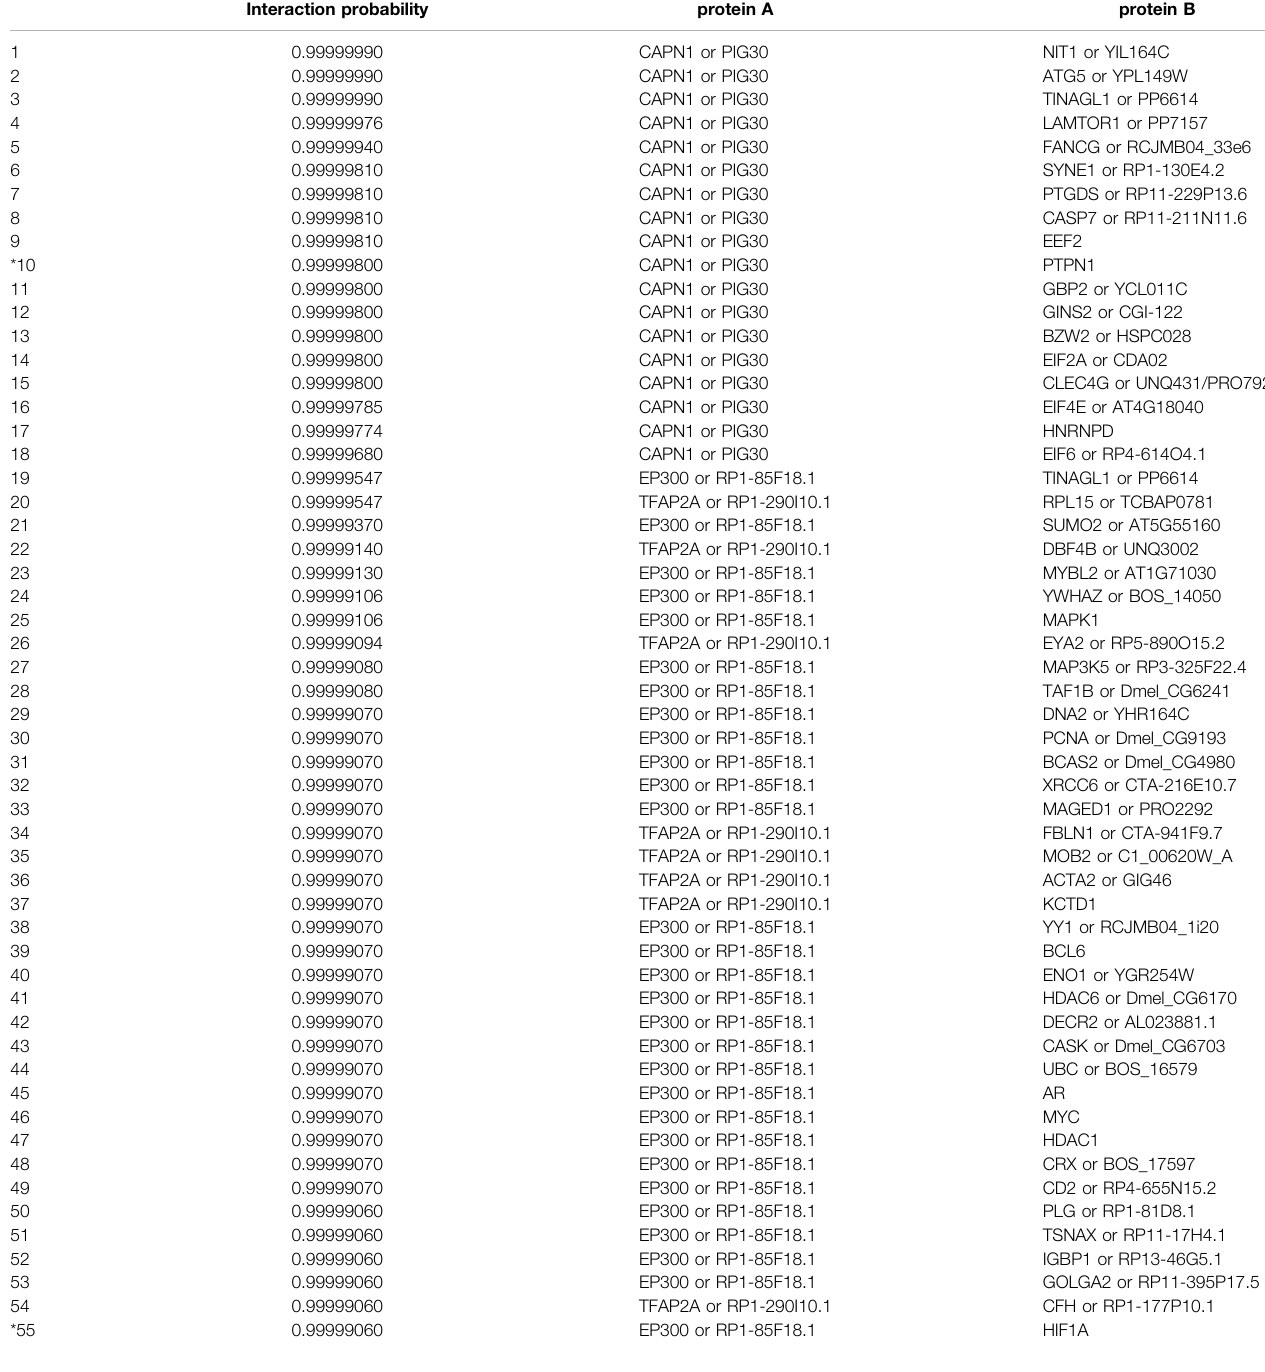
TABLE A1 | The top 55 protein – protein interactions and their probabilities from the intersection between our list of ranked interactions and the Interactome INSIDER database. The two marked interactions (10th and 55th) are discussed in detail in Sections 6.2 and 6.3 . The ‘ or ’ statements in the protein columns separate different names (synonyms) for the same